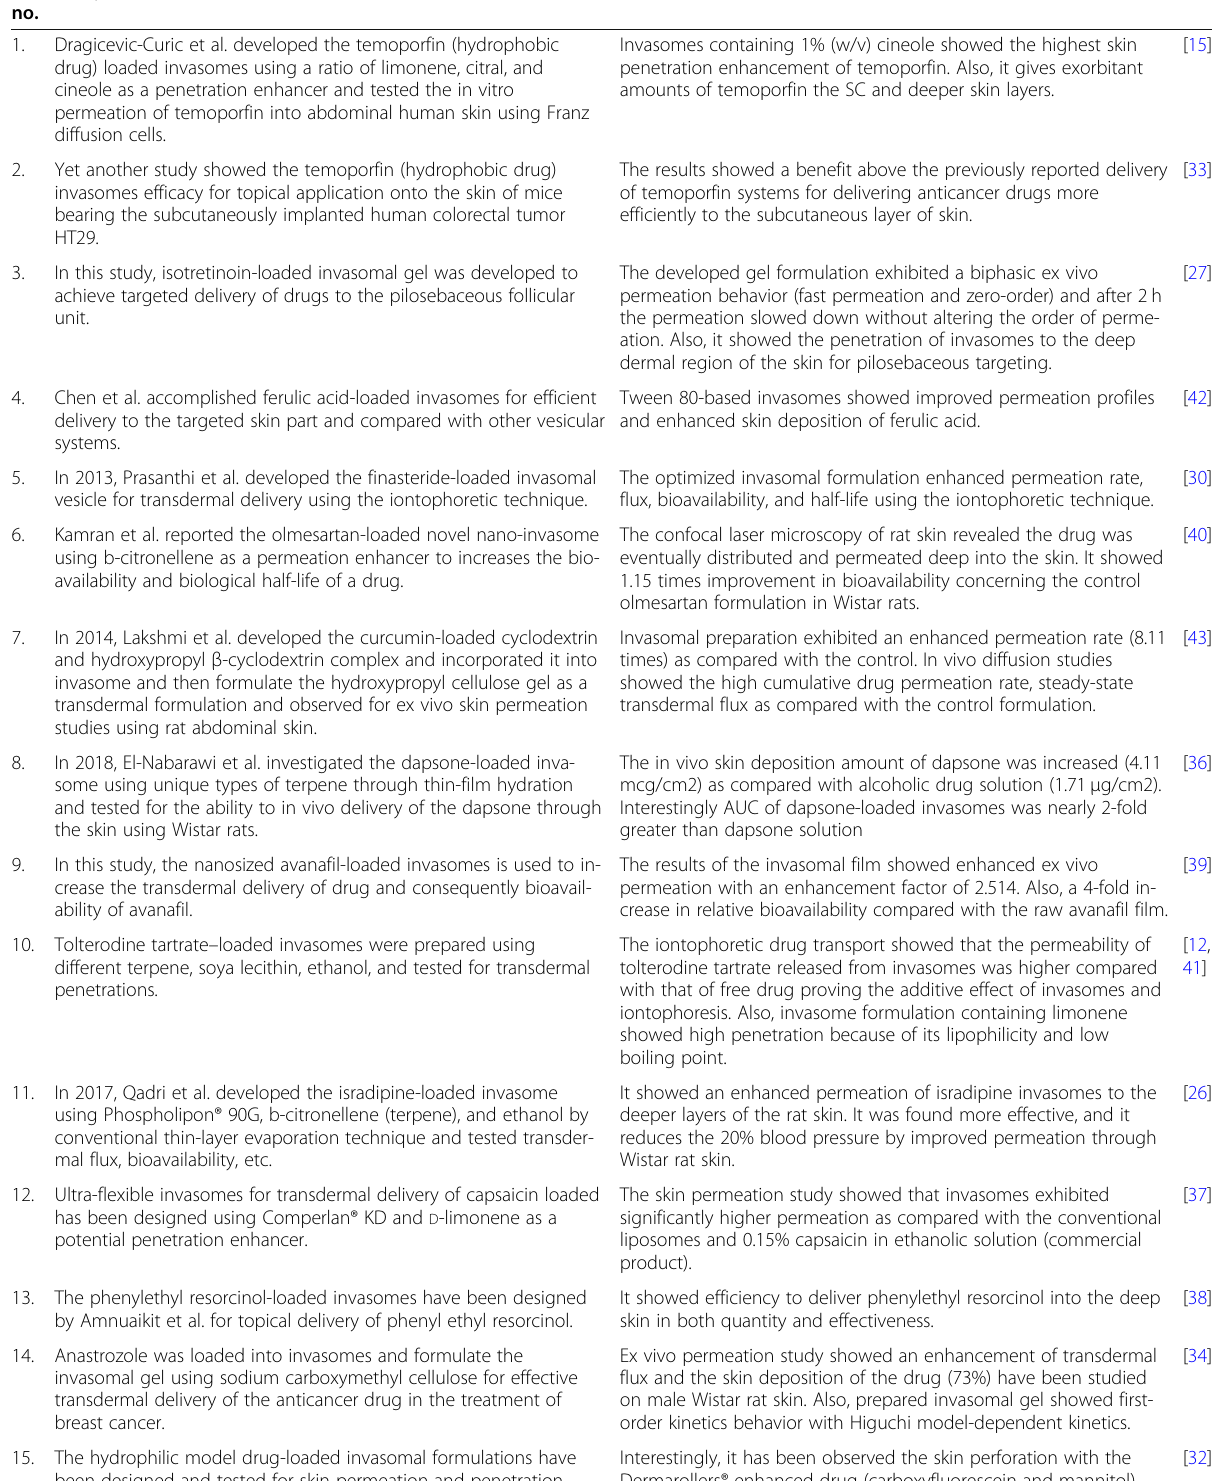
Table 3 Pharmacokinetic study of invasomes Sr. Study Result Ref. no.